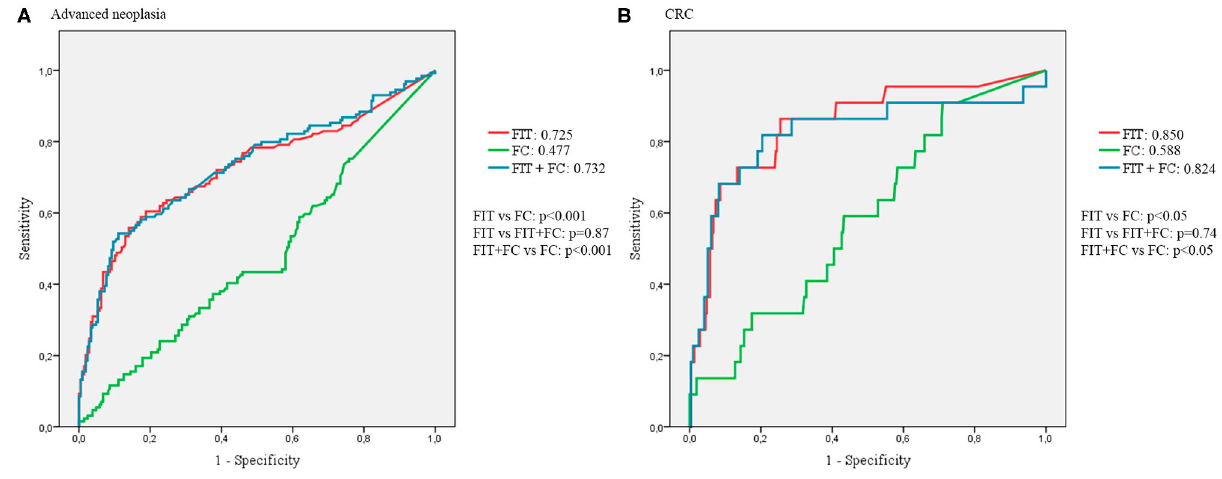
FIGURE 1 | AUCs of FIT, FC and its combination. (A) AUCs for the diagnosis of advanced neoplasia. (B) AUCs for the diagnosis of CRC.